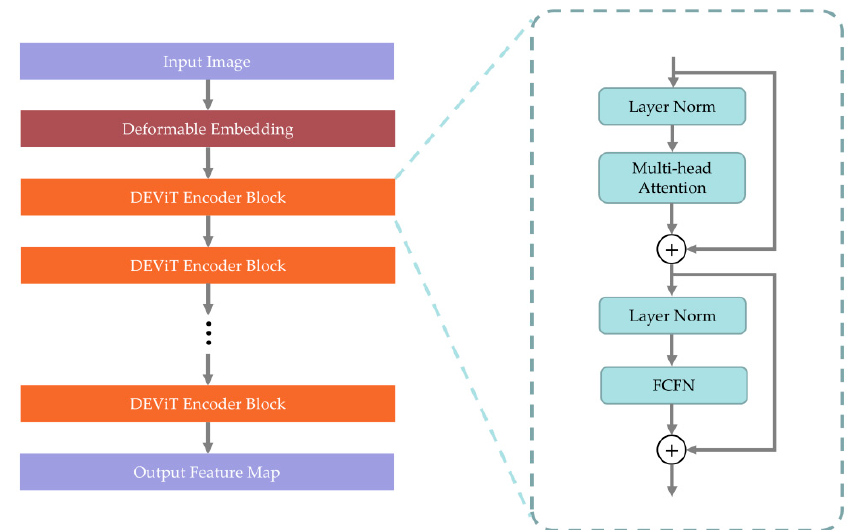
Figure 2. The DEViT architecture.